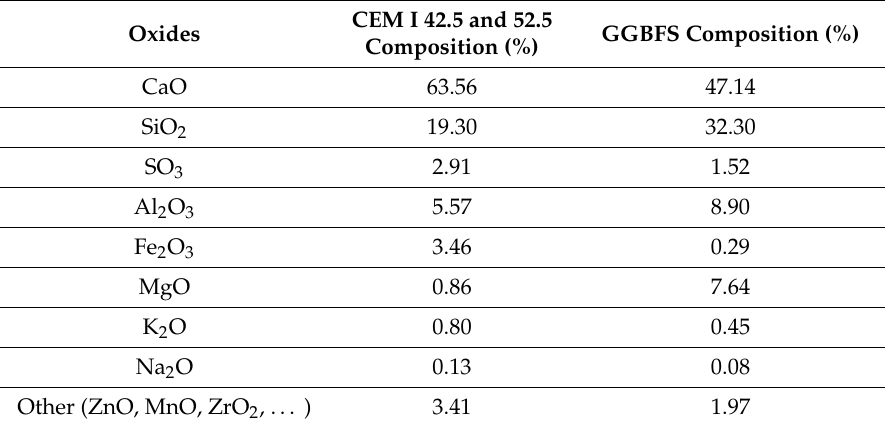
Table 1. Chemical composition of cement and